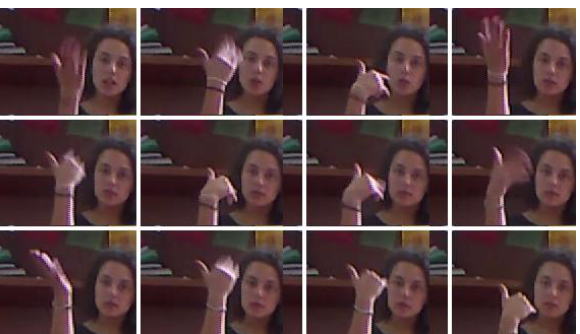
Figure 4. Sample00825, frames 189-232